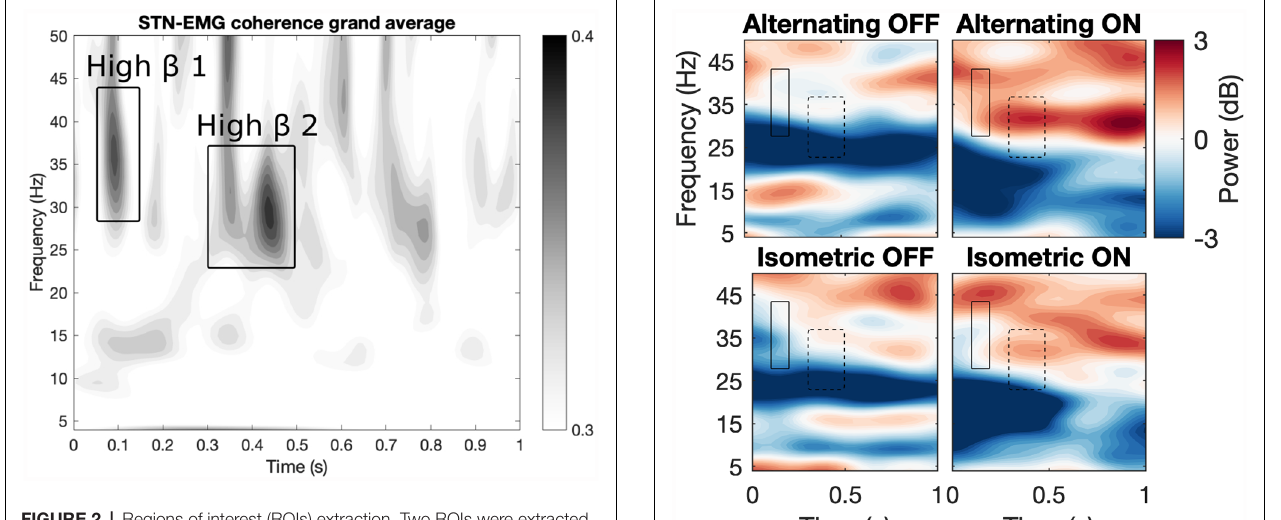
FIGURE 2 | Regions of interest (ROIs) extraction. Two ROIs were extracted from the grand average map of STN-EMG coherence. The map displays the average coherence across all conditions within the ranges 0–1 s and 4–50 Hz. Two sizeable ROIs were identified: “high beta 1” within 28–44 Hz